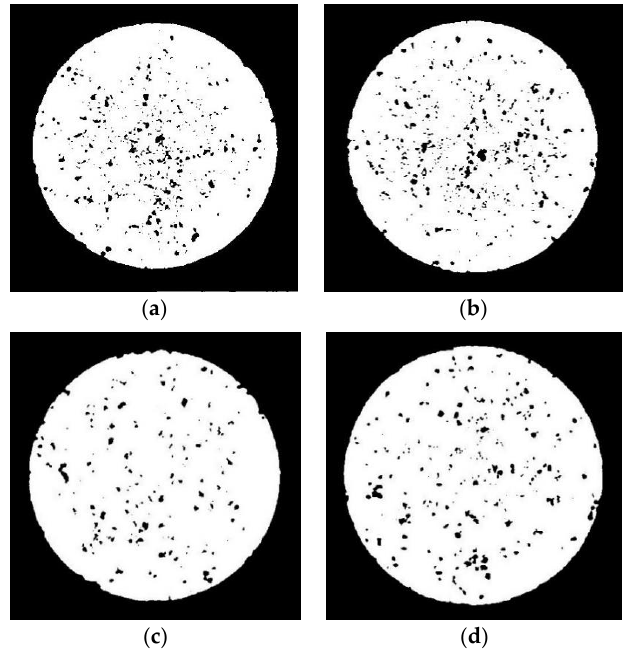
Figure 6. CT scan of sections: ( a ) 0 cycles of AM; ( b ) after five cycles of AM; ( c ) 0 cycles of NBAM; ( d ) five cycles of NBAM.